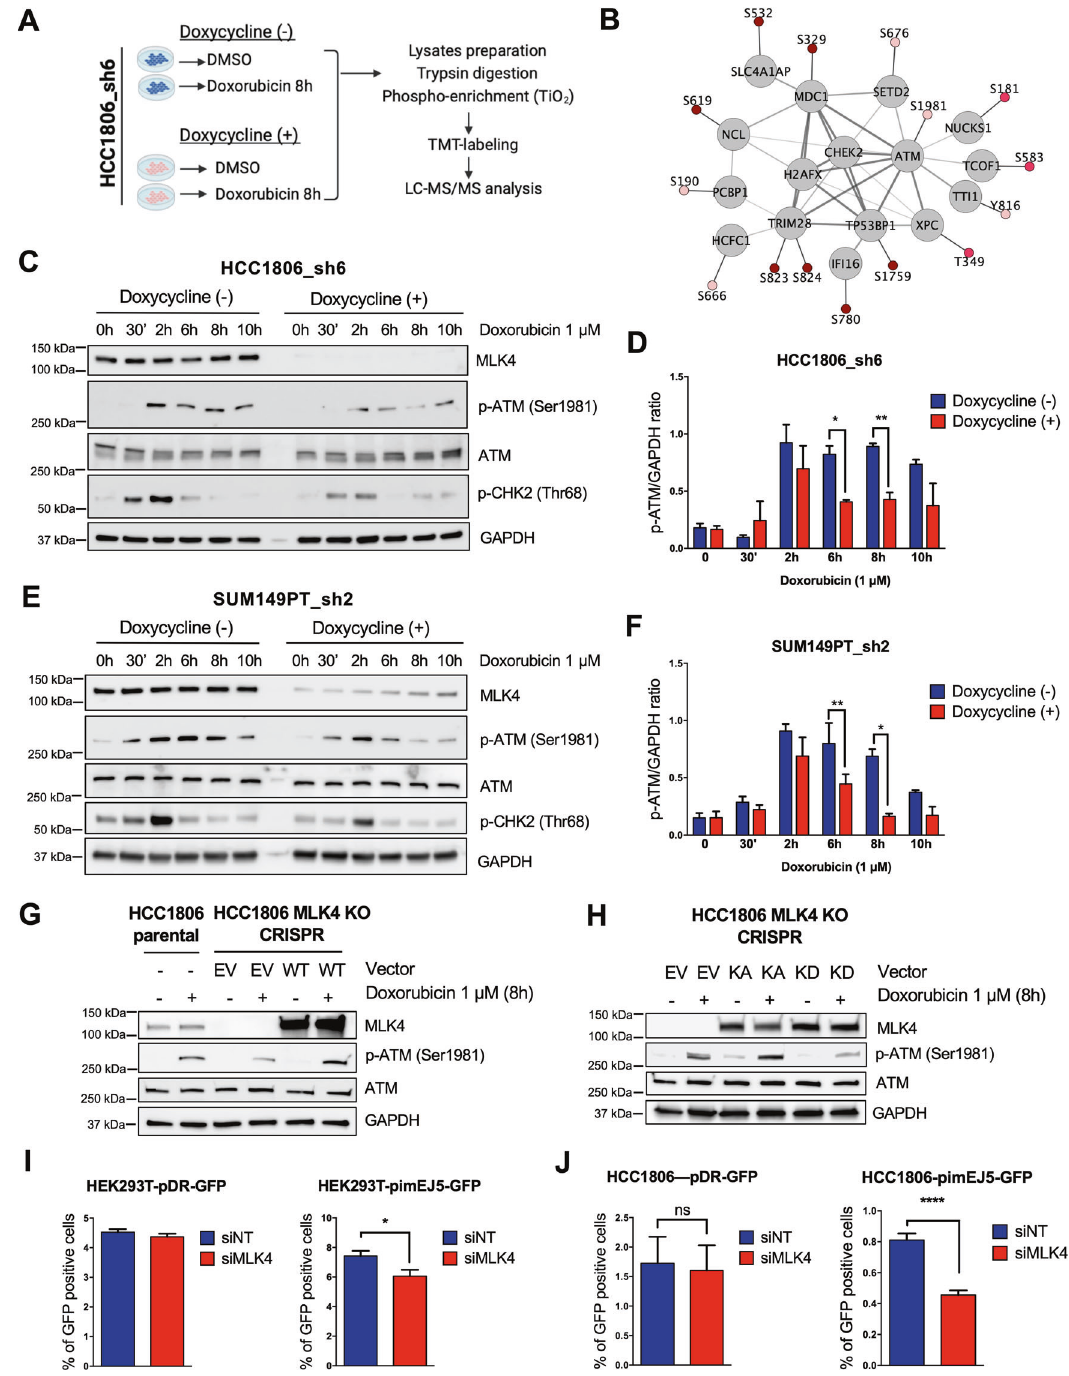
differentially regulated genes (Fig. 6A, B). Among these genes, we found numerous NF- κ B targets, including several cytokines and paracrine factors. Functional enrichment analysis of genes down- regulated following MLK4 depletion in doxorubicin-treated cells identi fi ed cytokine activity and receptor signaling as key down- stream targets of MLK4 (Fig. 6C). Furthermore, Gene Set Enrichment Analysis (GSEA) showed that NF- κ B signature was signi fi cantly downregulated in MLK4-depleted cells upon doxorubicin treatment (Fig. 6D). ATM activation and subsequent phosphorylation of